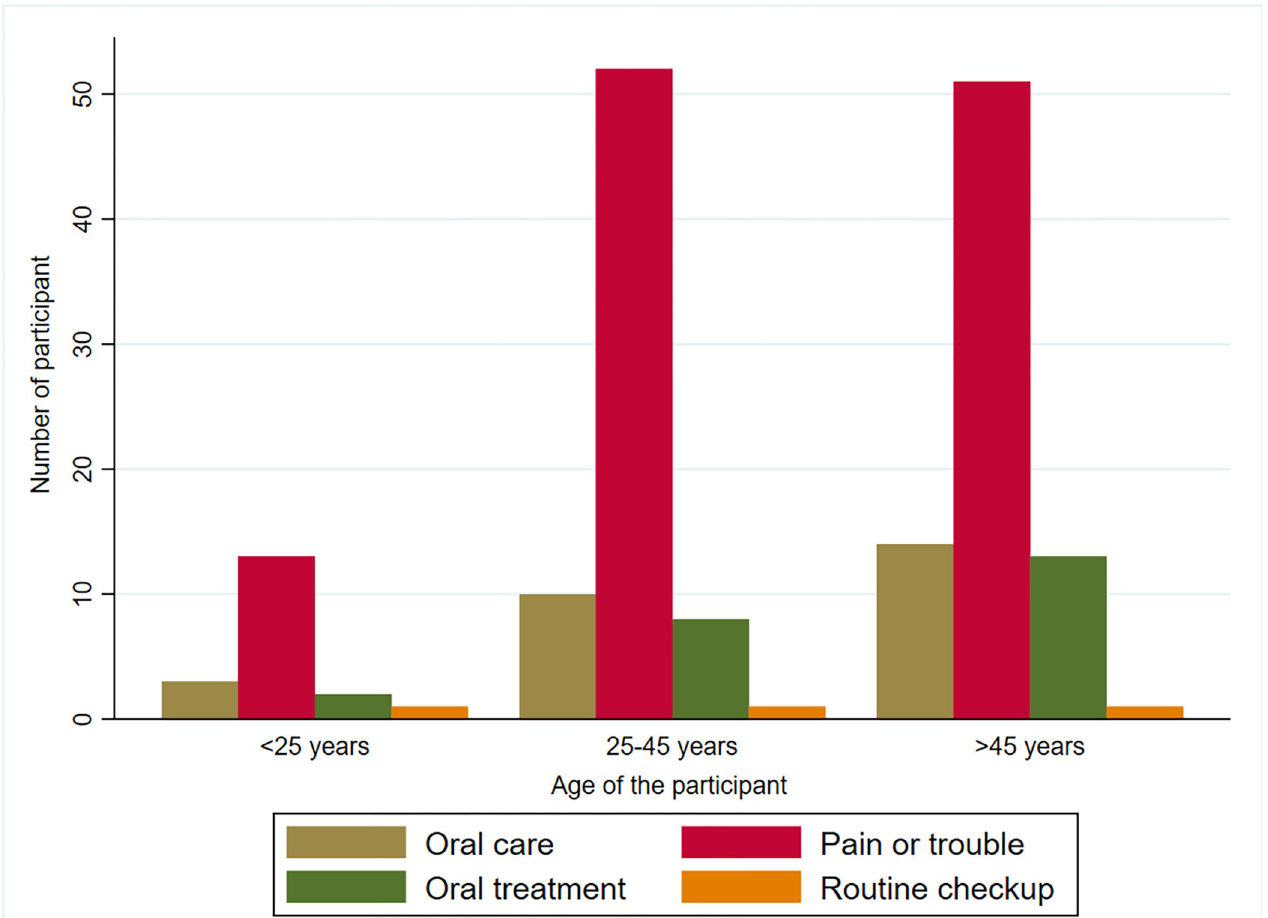
Fig 2. Bar showing the reason for last dental